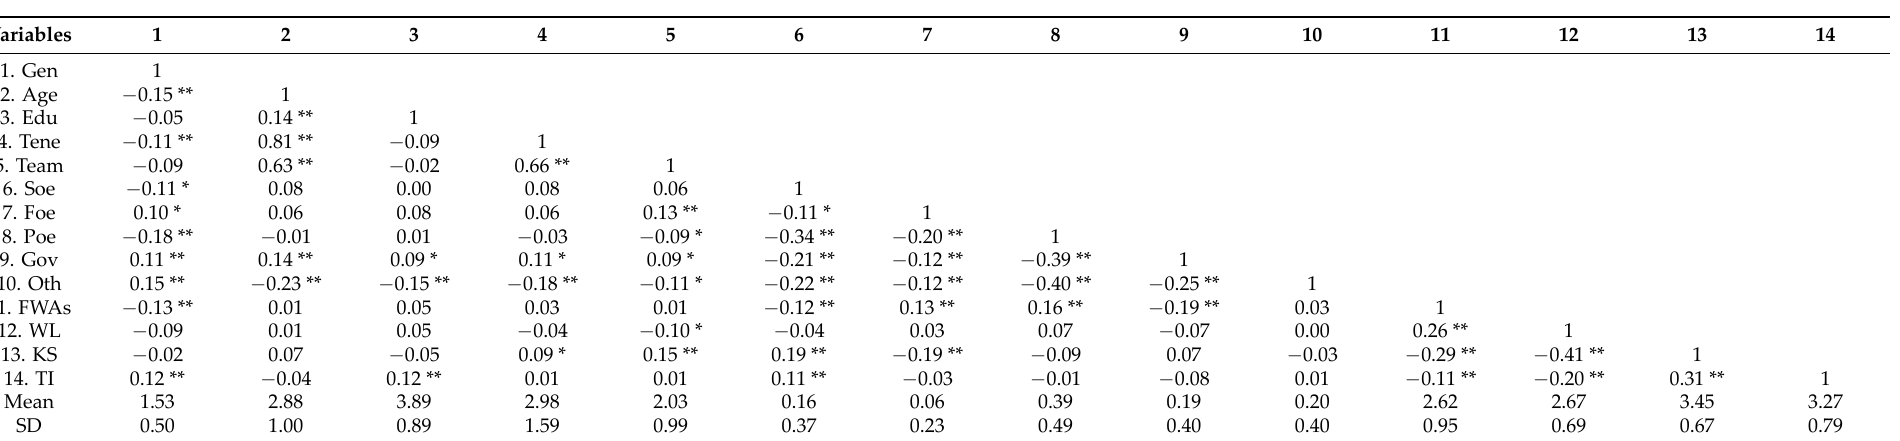
Table A1. Summary statistics and correlations of Study 1.